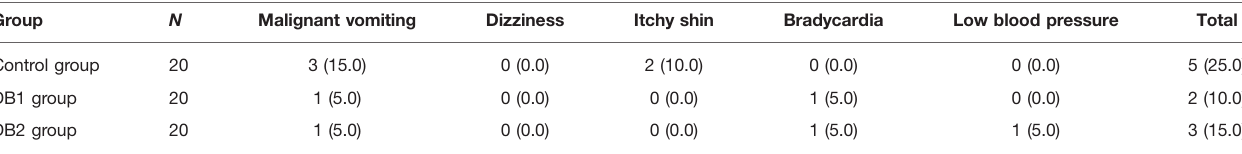
TABLE 8 | Comparison of adverse reactions at 48 h after surgery among three groups ( n , %).